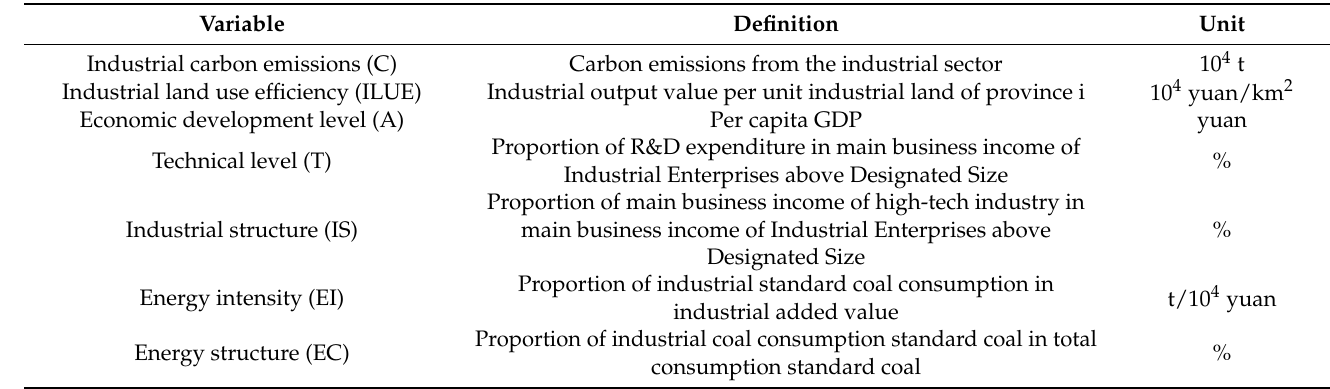
Table 1. Description of